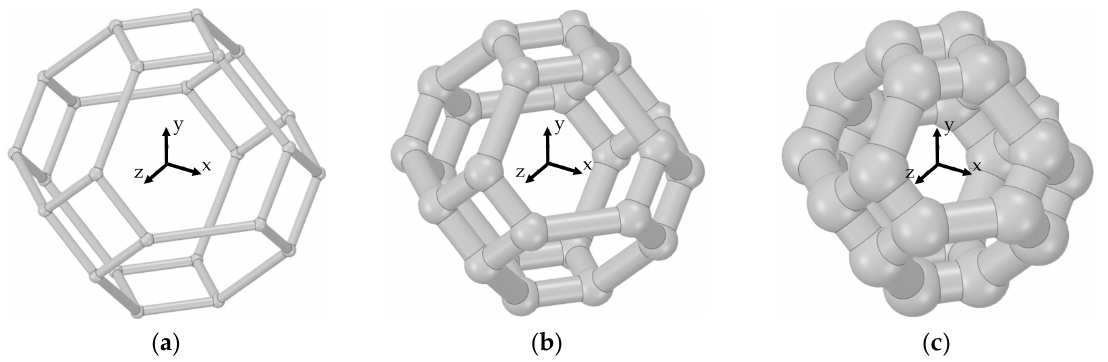
d : ( a ) d = 0.05 mm. ( b ) d = 0.15 mm. ( c ) f f f